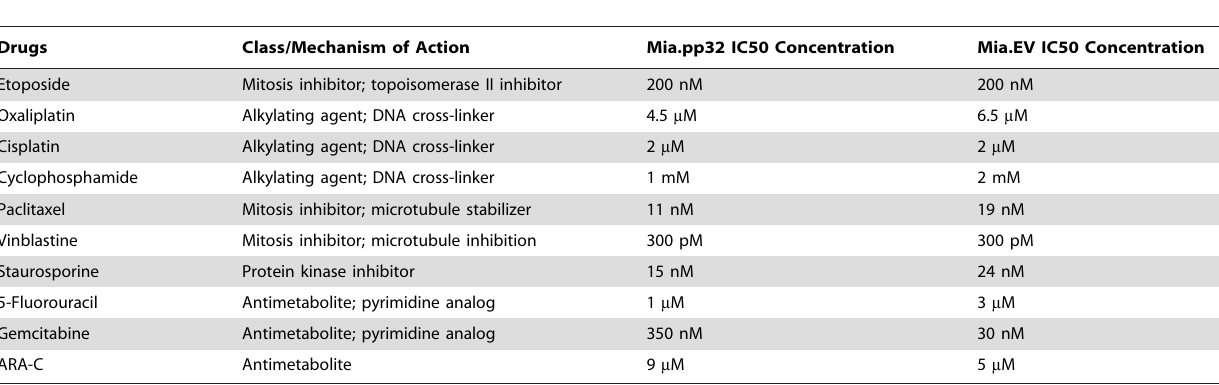
Table 1. Class of drugs used in the drug sensitivity assays performed against Mia.pp32 and Mia. EV cell lines with respective IC50s of each drug